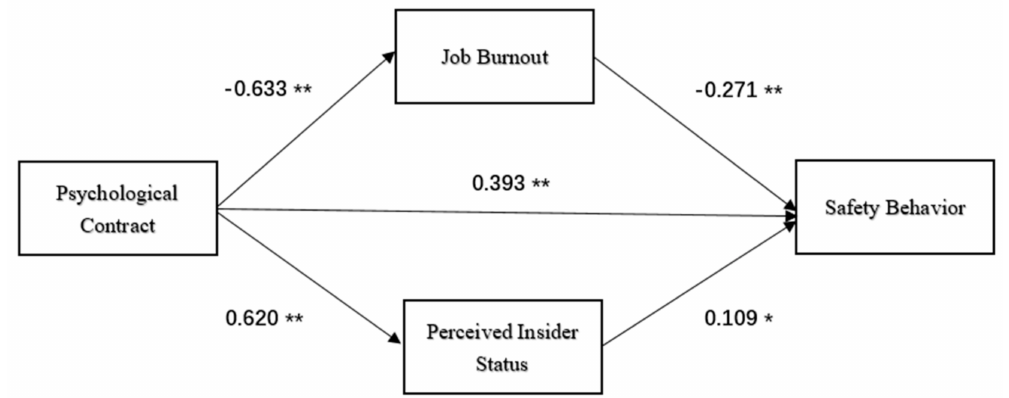
Figure 2. Double mediating e ff ect. N = 402, * is significantly correlated at 0.05 level (bilateral), ** is significantly correlated at 0.01 level